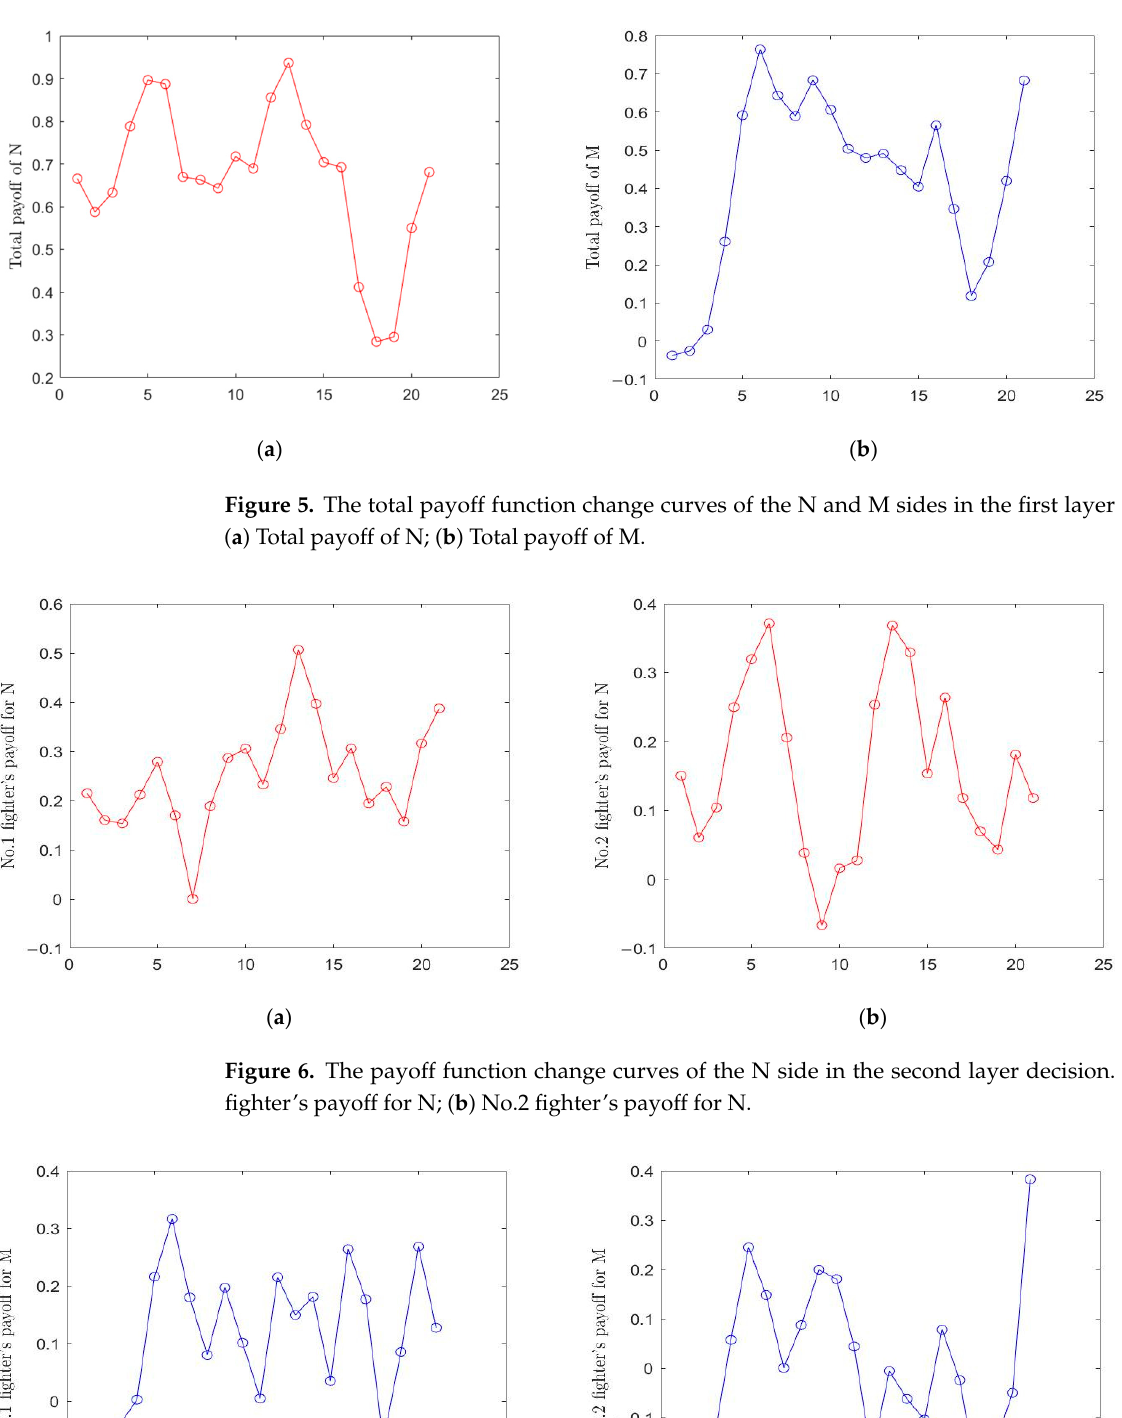
Figure 4. The air combat flight trajectories of four fighters. ( a ) The three-dimensional flight trajectory diagram; ( b ) The two-dimensional flight trajectory diagram.